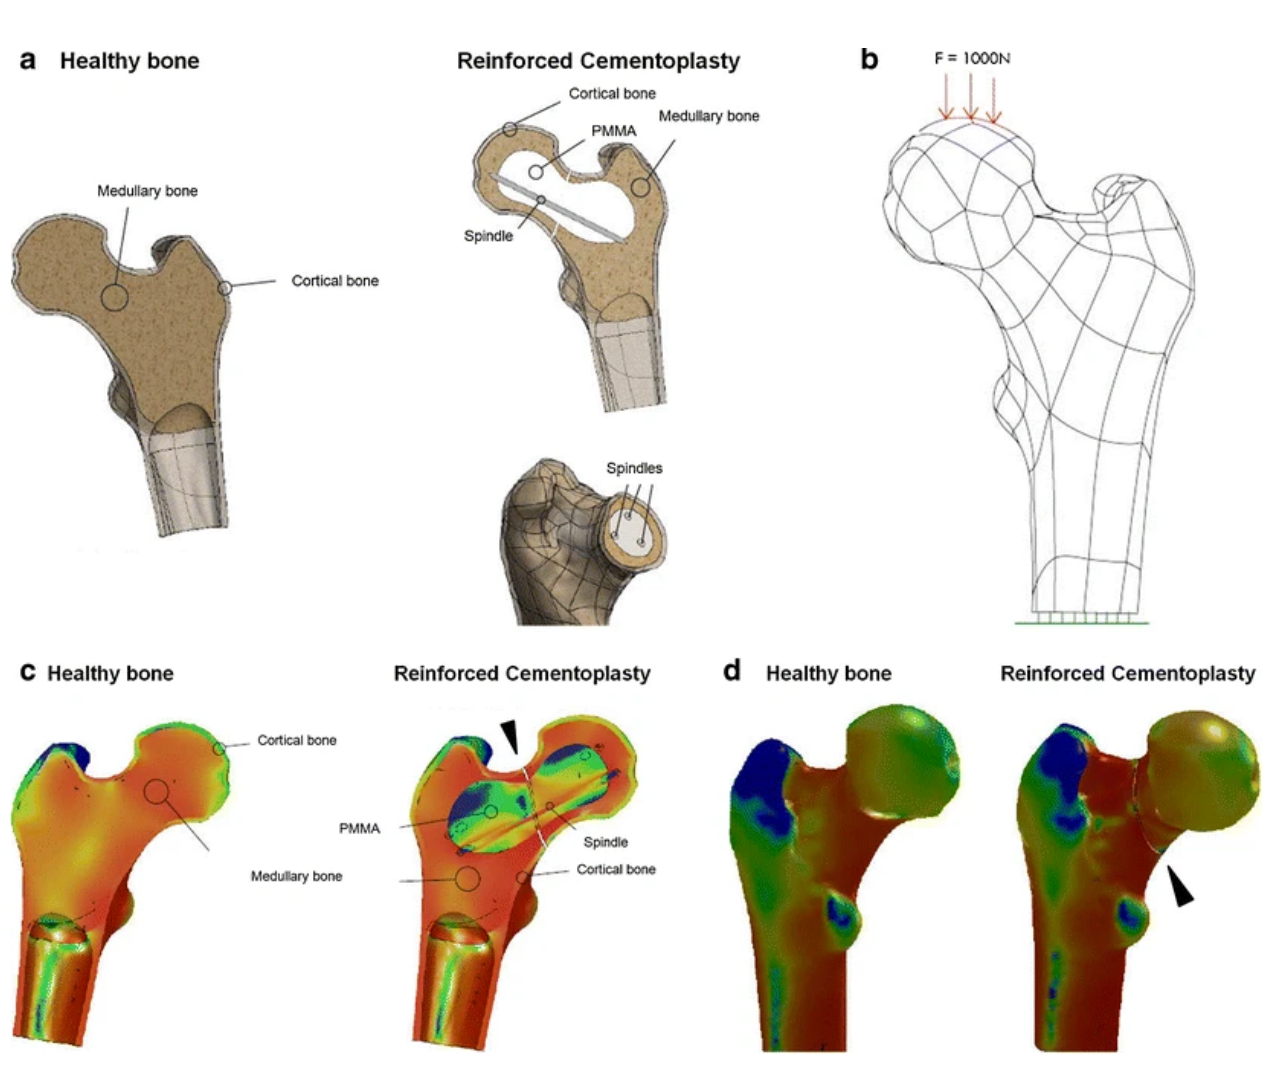
Figure 8. In silico testing of reinforced cementoplasty of the proximal femur [94]. ( a ) Normal healthy bone (left) and a diseased bone (right) model that received cementoplasty plus spindles, ( b ) proximal femur loading (1000 N) to simulate physiological loading conditions, color-coded depiction of forces ( c ) within, and on the ( d ) surface of cervicotrochanteric region (red—high magnitude forces, blue—low magnitude forces). A fracture line was included in the diseased bone to model the femoral neck fracture (shown by black arrowhead). No significant difference in mechanical constraints was observed between the normal bone and RC-repaired bone. The simulations were executed in Solidworks software (Dassault Systèmes, France). (Reprinted with permission, © 2017 Springer, [94]).